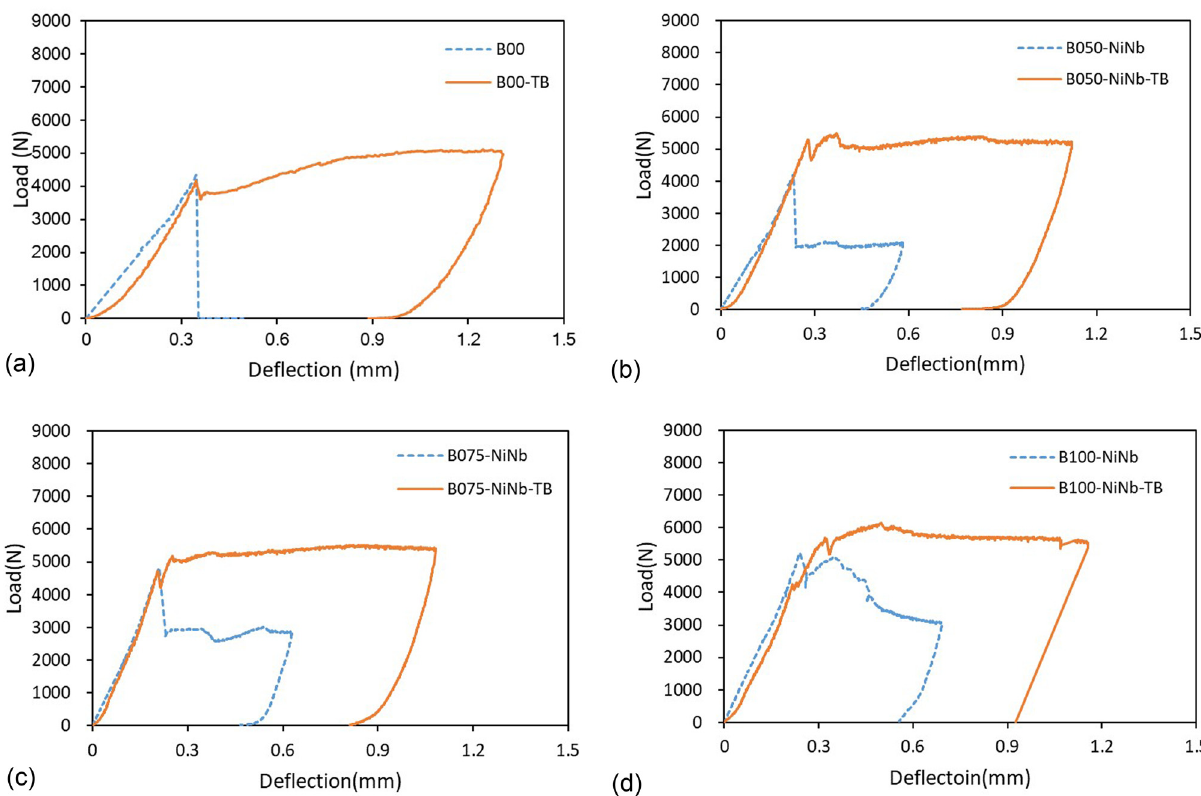
Figure 4: Example of load and de fl ection curves of the beam specimens with and without tensile wires: ( a ) v f = 0%, ( b ) v f = 0.50%, ( c ) v f = 0.75%, and ( d ) v f =